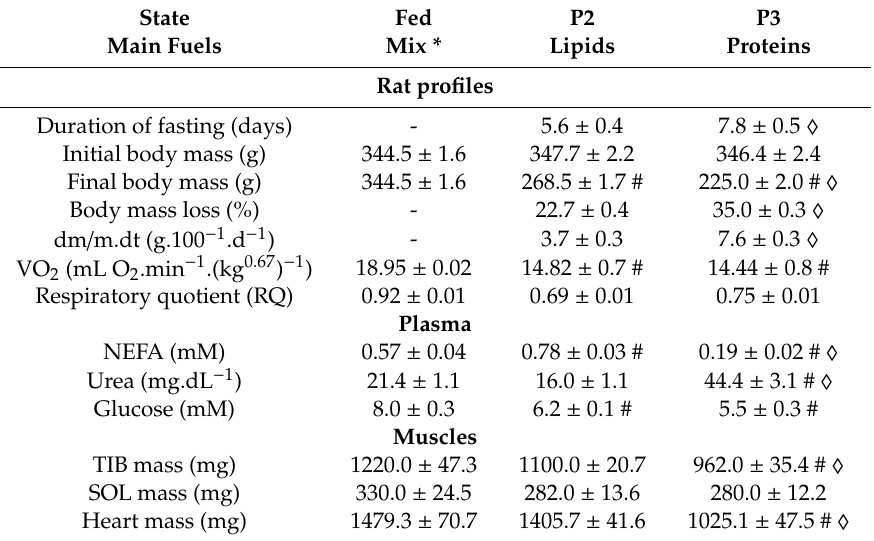
Table 1. Characteristics of fed and fasted